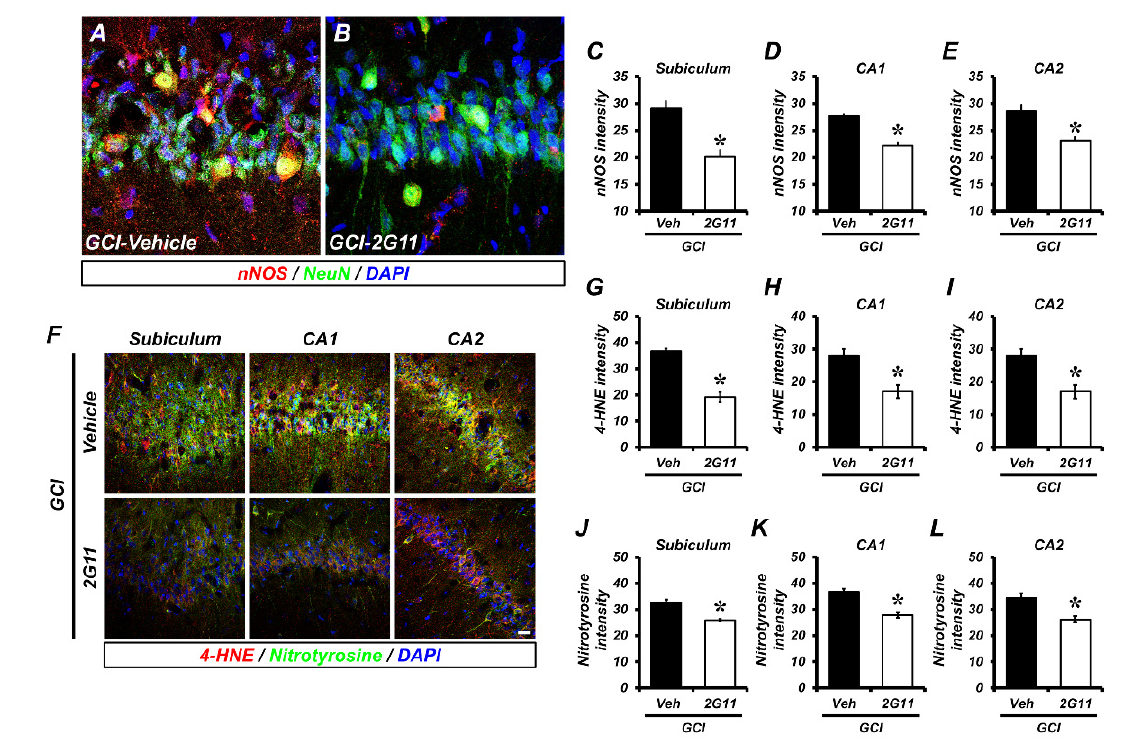
Figure 3. The 2G11 treatment reduced oxidative damage after GCI. ( A , B ) Representative images of NeuN (green) and nNOS (red) double immunostaining on the hippocampal CA1 from the vehicle- and 2G11-treated groups after GCI. Nuclei are stained with DAPI (blue). Scale bar = 10 μ m. ( C–E ) Quantification of the immunofluorescence intensity of nNOS immunoreactivity as determined in the subiculum, CA1, and CA2 regions of the hippocampus. Data are the mean ± SEM; n = 4. * p < 0.05 vs. the vehicle-treated GCI group (Mann–Whitney U test, C: z = 2.309, p = 0.029; D: z = 2.309, p = 0.029; E: z = 2.309, p = 0.029). ( F ) Double-label confocal micrographs of nitrotyrosine (green) and 4-HNE (red) in the hippocampal subiculum, CA1, and CA2 for detecting lipid peroxidation and nitrosative stress, respectively. Nuclei are stained with DAPI (blue). Scale bar = 20 µ m. ( G – L ) Bar graphs showing the fluorescence intensity of 4-HNE ( G – I ) and nitrotyrosine ( J – L ) immunoreactivity in the same hippocampal region after GCI. Data are the mean ± SEM; n = 5. * p < 0.05 vs. the vehicle-treated GCI group (Mann–Whitney U test, G: z = 2.611, p = 0.008; H: z = 2.611, p = 0.008; I: z = 2.611, p = 0.008; J: z = 2.842, p = 0.003; K: z = 2.842, p = 0.003; L: z = 2.517, p = 0.01).